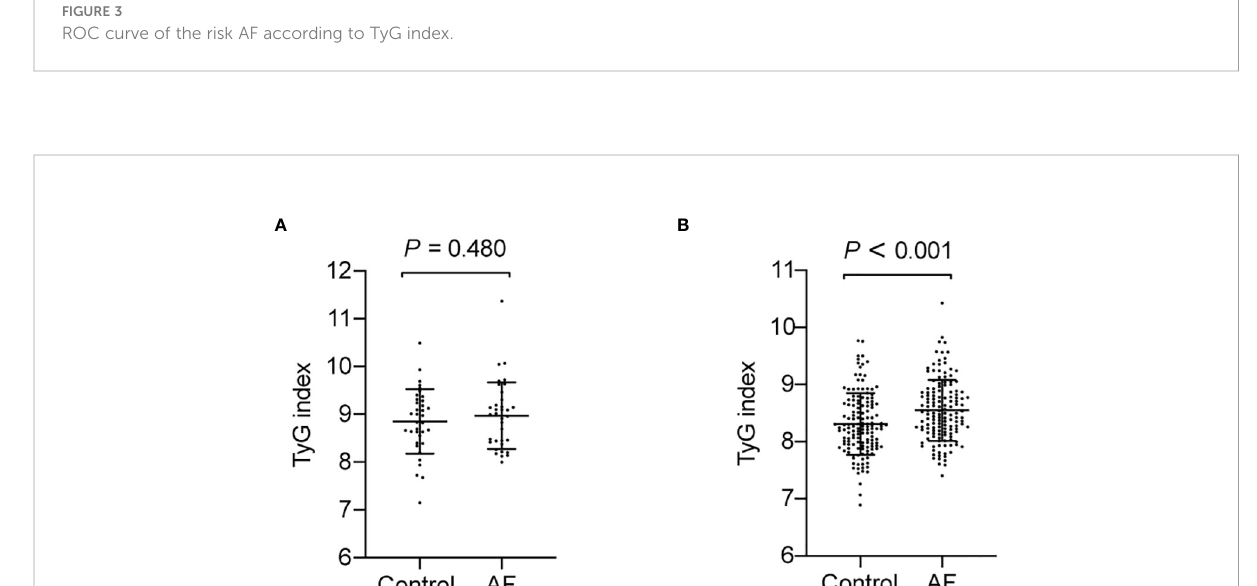
FIGURE 4 The TyG index in AF group and control in diabetic and non-diabetic subjects. (A) The TyG index is no signi fi cantly difference in diabetic subjects ( P = 0.480). (B) The TyG index is increased in non-diabetic subjects with AF ( P < 0.001).